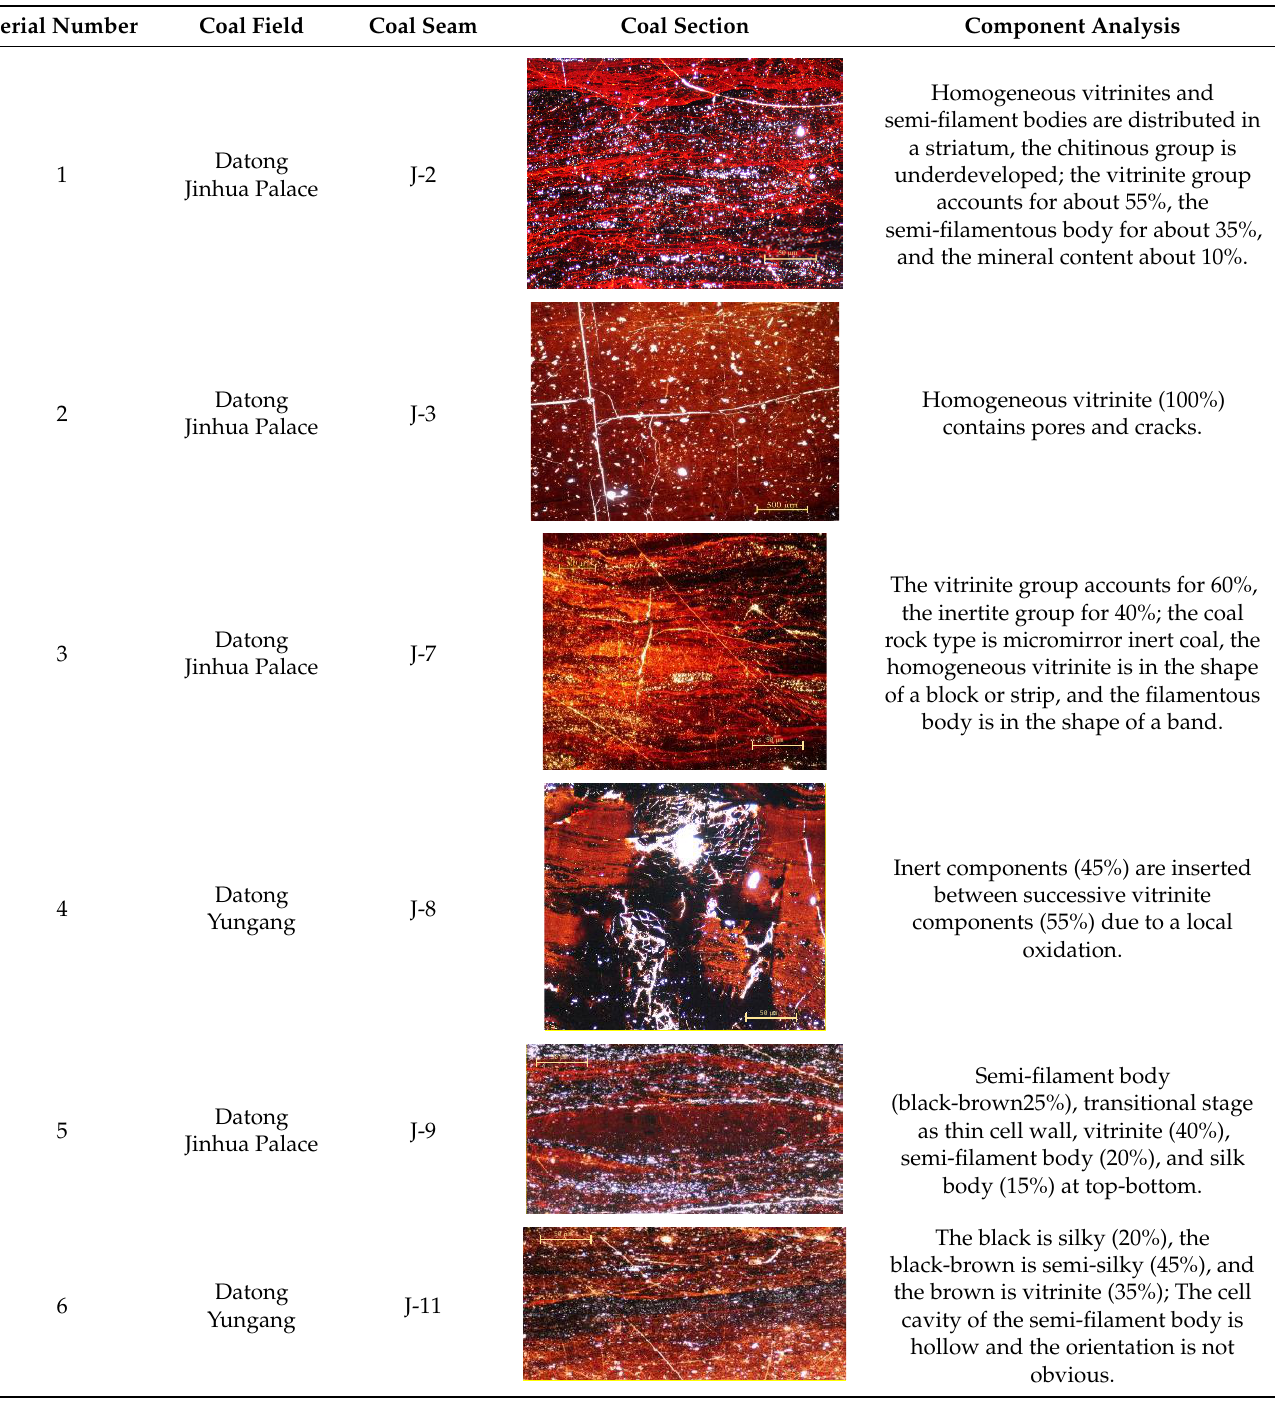
Table 2. Microscopic observation characteristics of coal slices from different layers of the Datong Coalfield and Fushun Open-pit Mine.